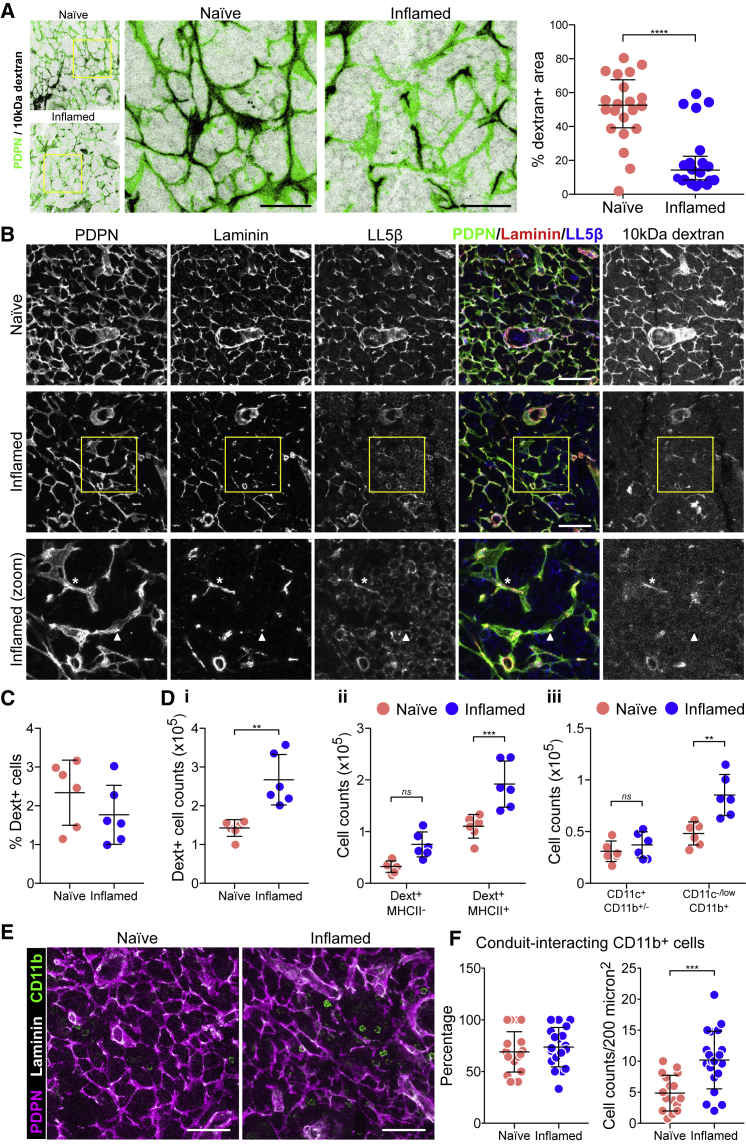
Conduit Flow and Antigen Uptake in Inflamed LNsMice were immunized by the subcutaneous injection of IFA/OVA on the right flank. Five days later, fluorescently labeled 10 kDa dextran was injected on both flanks.(A) Immunofluorescence of 20-μm-thick cryosections of naive and inflamed draining LNs 30 min post-dextran injection. Maximum z stack projections. Scale bars, 40 μm. Graph shows the percentage of dextran+ areas within the PDPN+ network. Each dot represents a different region of interest. Regions of interest are collated from 6 individual mice per group. Error bars represent means and SDs. ∗∗∗∗p < 0.0001, unpaired t test.(B) Immunofluorescence of 20-μm-thick cryosections of naive and inflamed draining LNs 30 min post-dextran injection. Maximum z stack projections. Scale bars, 20 μm. The asterisk indicates a portion of the FRC network with all conduit components plus dextran flow. The arrowhead indicates a portion of the FRC network in which the conduit is not present and dextrans are not flowing.(C) Percentage of dextran+ cells as quantified by flow cytometry 90 min after dextran injection. Error bars represent means and SDs.(D) The number of dextran+ cells per LN (i); the number of MHCII+ dextran+ cells (ii); the number of dextran+ cells within myeloid subsets (iii). Each dot represents an individual mouse (n = 6). Error bars represent means and SDs.(E) Representative images of CD11b+ myeloid cells in cryosections of the fibroblastic reticular network. Scale bars, 20 μm.(F) Quantification of the percentage (left) and the number (right) of CD11b+ myeloid cells interacting with conduit structures from regions of interest from 5 biological replicates. Error bars represent means and SDs.